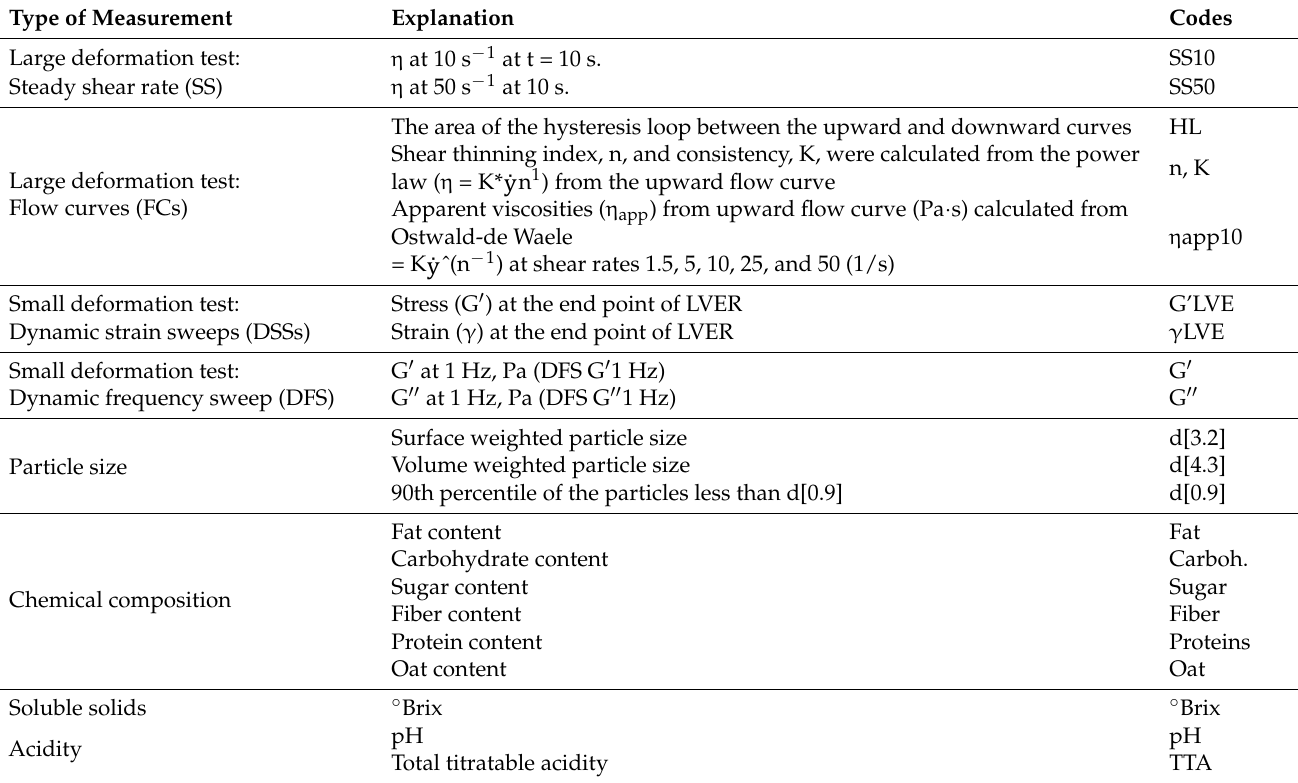
Table 2. Overview of the physicochemical parameters extracted from instrumental